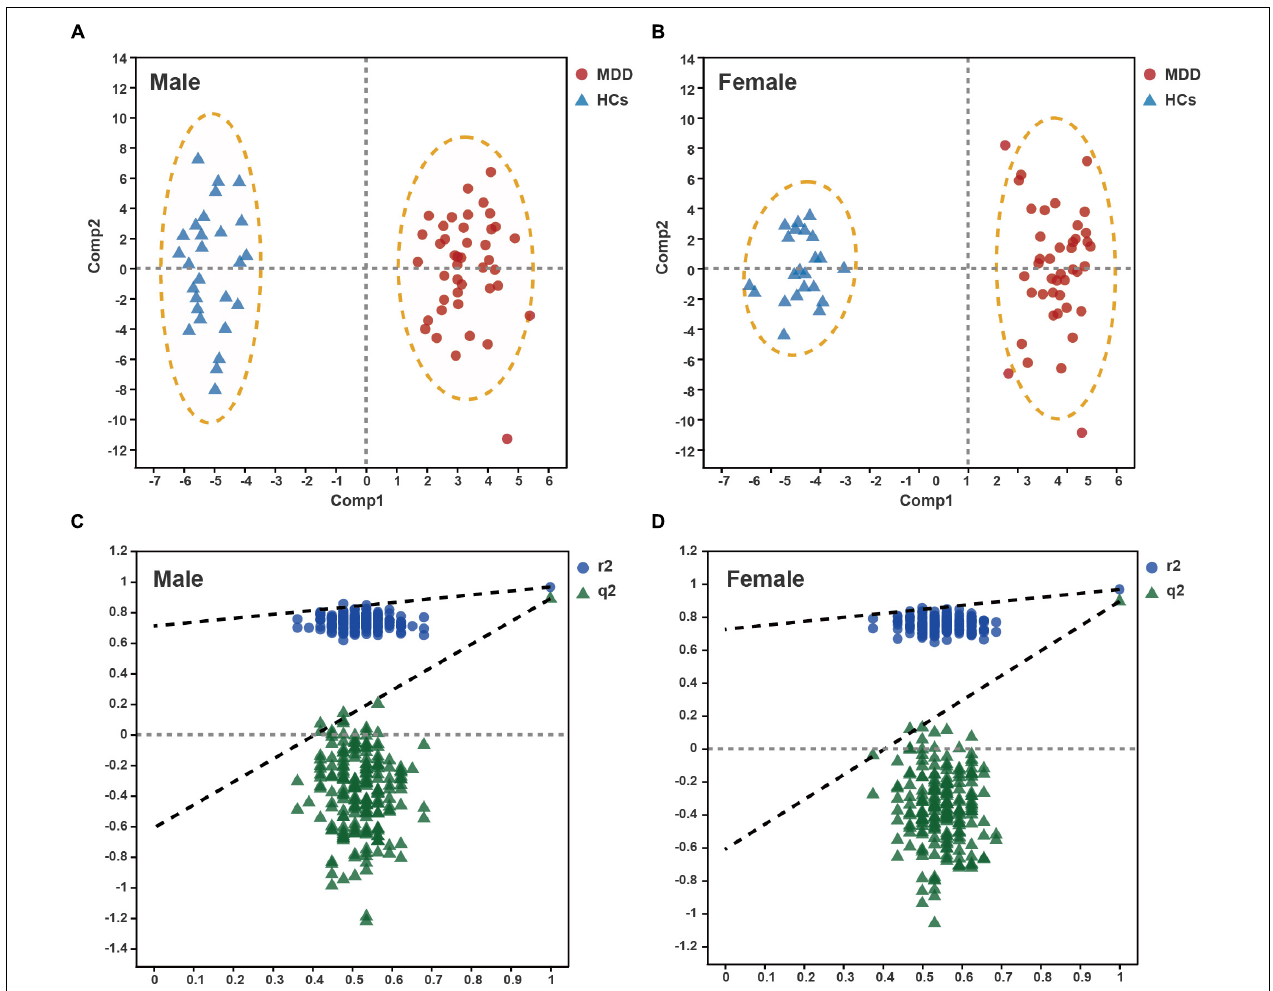
FIGURE 1 | Metabolomic analysis of plasma from male and female patients with major depressive disorder (MDD) vs. healthy controls (HCs). Orthogonal partial least squares discriminate analysis (OPLS-DA) score plots displayed clear discrimination between male (A) and female (B) subjects with MDD from their respective HCs. Permutation test for male (C) and female (D) OPLS-DA